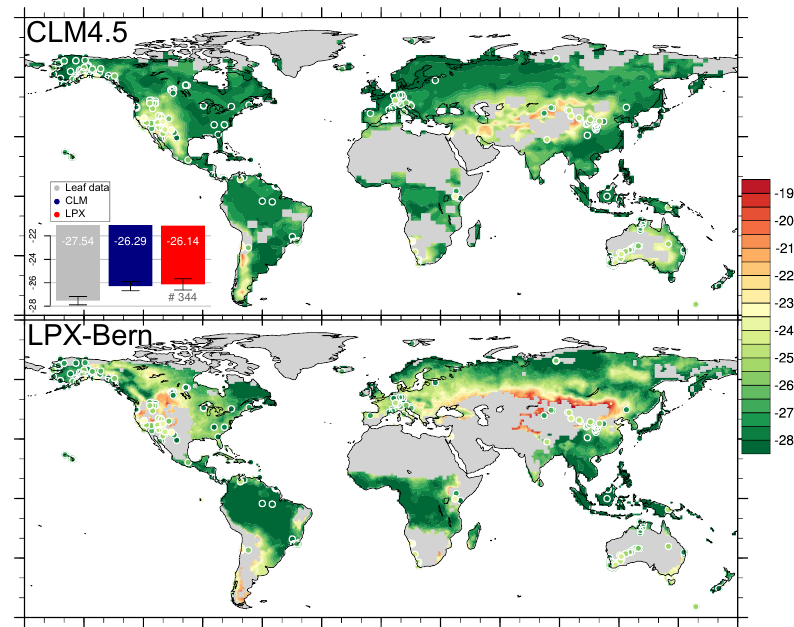
Figure 5. δ 13 C as measured on leaves of C3 trees (colored circles; Cornwell et al., 2016) and as simulated by (a) CLM4.5 and (b) LPX (shading) for the decade 1996 to 2005. Samples for the measurements were taken between 1975 and 2014. The bar plot shows the average over all measurements (gray) and the average signature of C3 trees of the corresponding grid cells for CLM4.5 (blue) and LPX (red). The number below the red bar indicates the number of available